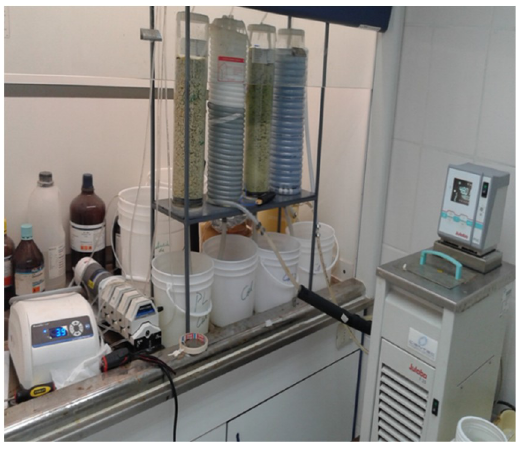
Figure 1. Mini-column leaching tests. Table 4. Experimental conditions of mini-column leaching tests.